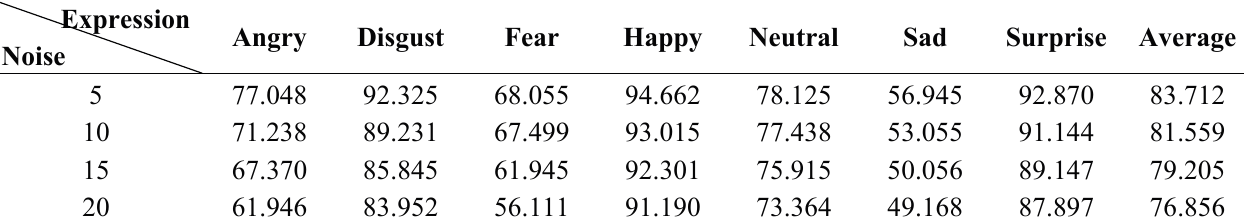
Table 5. Recognition rate of SR over noisy images.